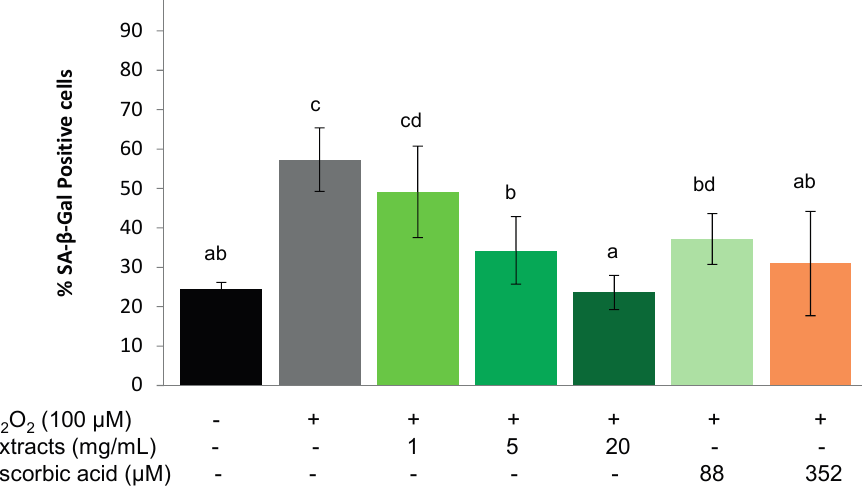
Figure 4. Protective effect of S. oleraceus leaf extracts on H 2 O 2 treated WI-38 cells. Cells were treated with 1, 5 or 20 mg/mL S. oleraceus leaf extracts or 88 or 352 µM ascorbic